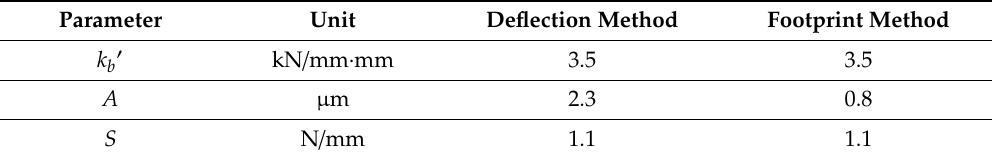
Table 3. Parameters for representing the contact deflection of the grinding wheel WA60J8V.